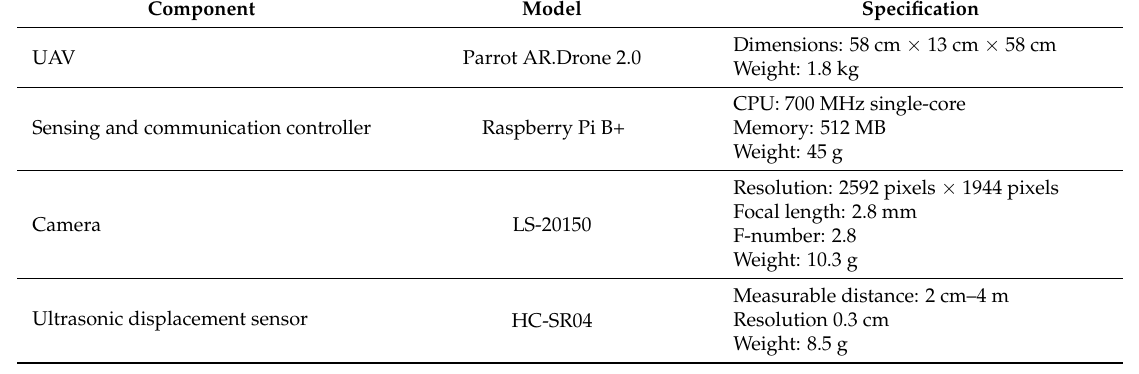
Table 1. System components.